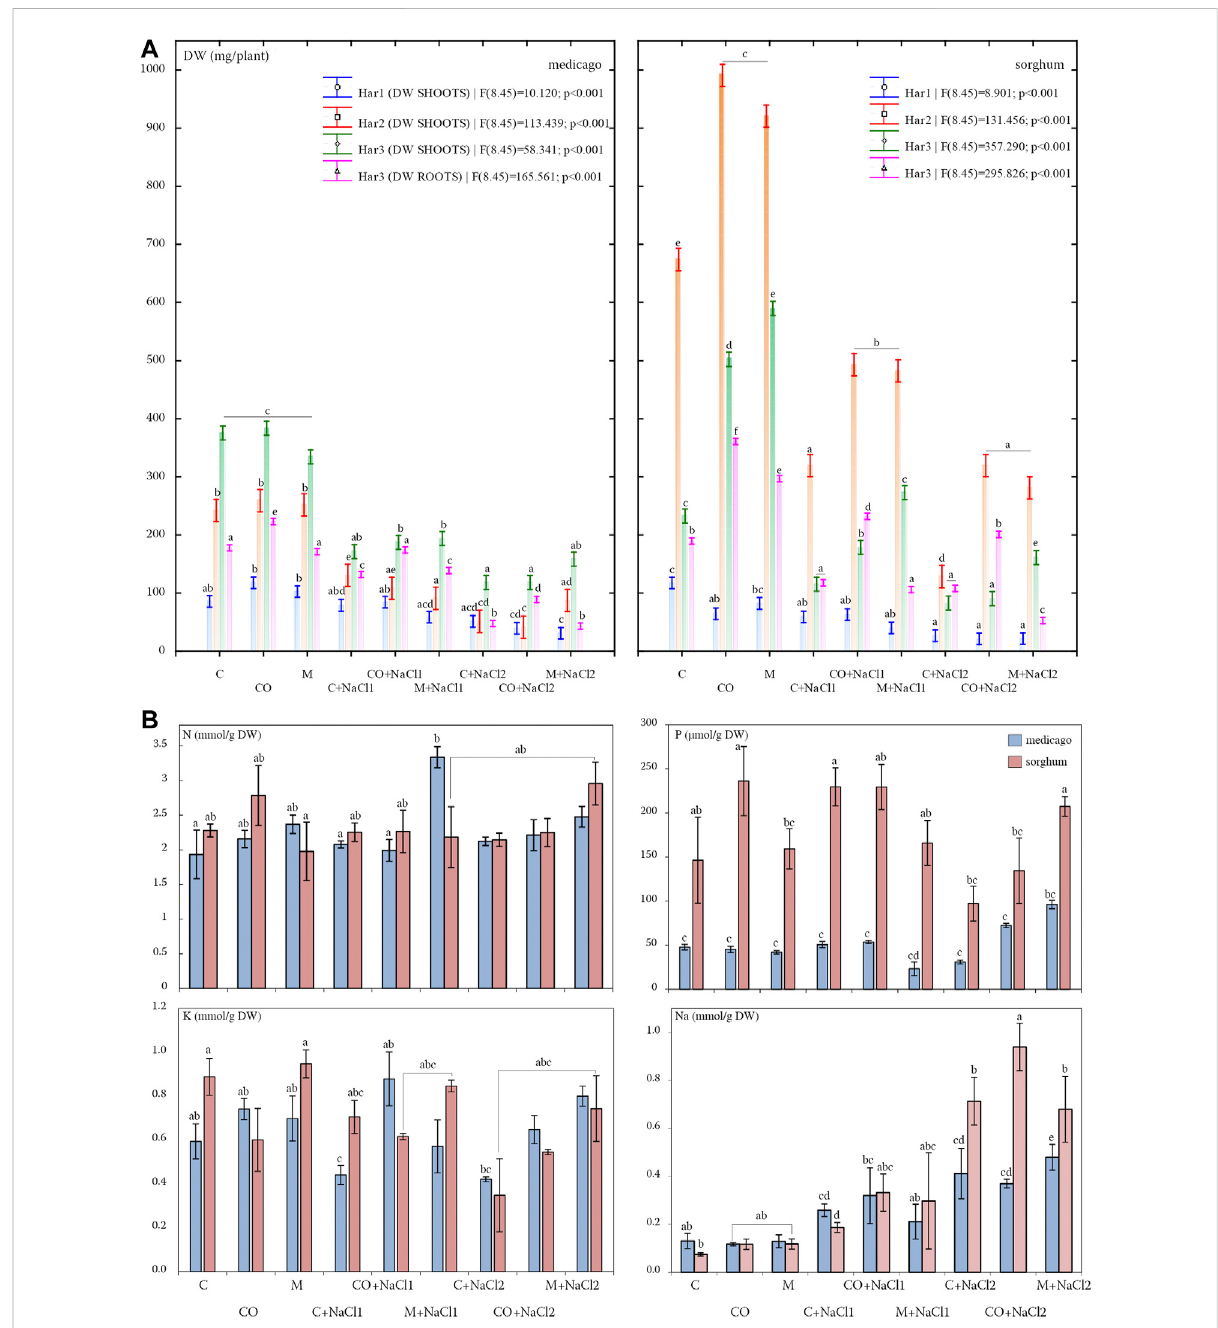
FIGURE 1 (A) Effect of municipal solid waste compost (CO) and farmyard manure (M) supplementation on biomass yield in alfalfa and sorghum. The treatments indicate, control (C); municipal solid waste compost (CO); livestock farmyard manure (M); control with 50 mM NaCl (C + NaCl1); municipal solidwastecompostwith50 mMNaCl(CO+NaCl1);livestockfarmyardmanurewith50 mMNaCl(M+NaCl1);controlwith100 mMNaCl(C+NaCl2); municipal solid waste compost with 100 mM NaCl (CO + NaCl2); livestock farmyard manure with 100 mM NaCl (M + NaCl2). The H1, H2, and H3 presents the consequtive harvests. The different letters above the bar colums indicate signi fi cant diffences of mean ± SE at p < 0.05 . Figure 1. (B) Acumulation of nitrogen, potassium, phosphorus and sodium in alfalfa and sorghum under saline soil with municipal solid waste compost (CO) and farmyard manure (M) supplementation on biomass yield in alfalfa and sorghum. The treatments indicate, control (C); municipal solid waste compost (CO); livestock farmyard manure (M); control with 50 mM NaCl (C + NaCl1); municipal solid waste compost with 50 mM NaCl (CO + NaCl1); livestock farmyard manure with 50 mM NaCl (M + NaCl1); control with 100 mM NaCl (C + NaCl2); municipal solid waste compost with 100 mM NaCl (CO + NaCl2);livestockfarmyardmanurewith100 mMNaCl(M+NaCl2). Thedifferentlettersabovethebarcolumsindicatesigni fi cantdiffencesofmean±SE at p < 0.05